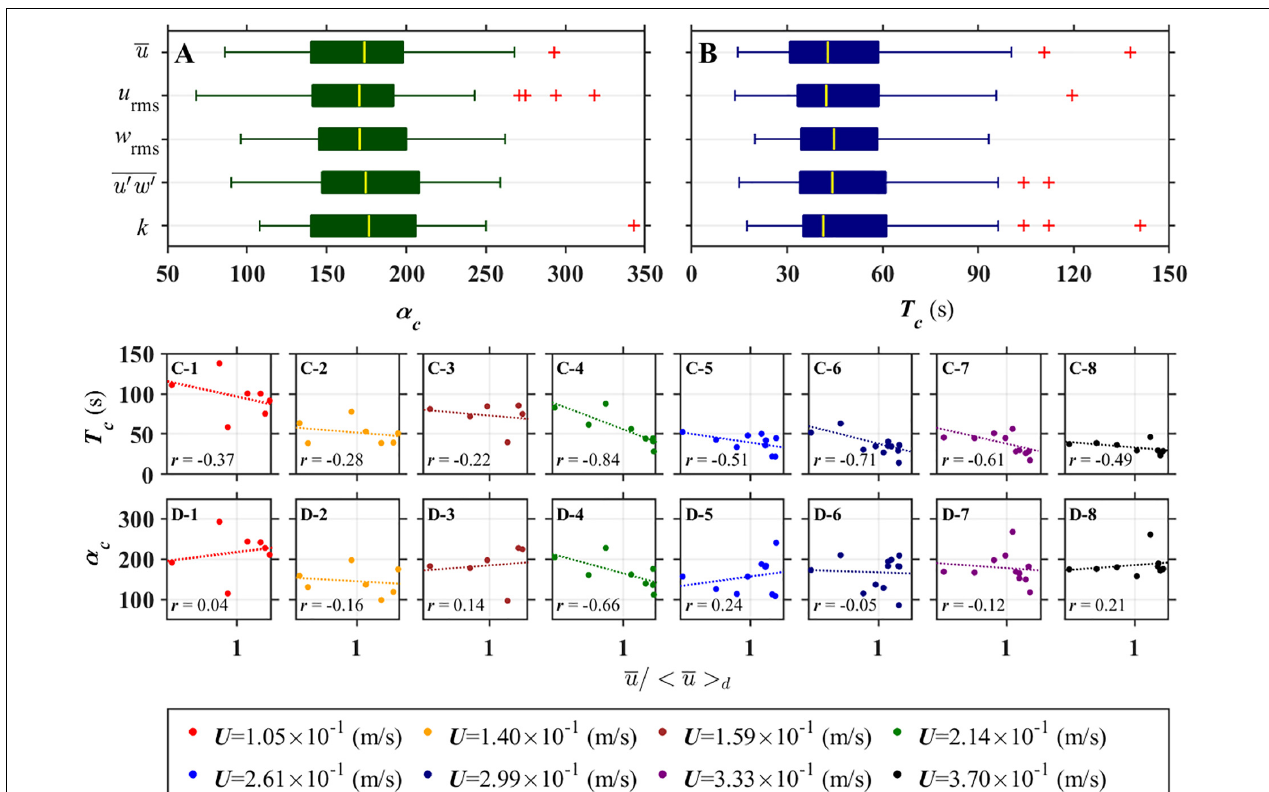
FIGURE 5 | Optimal sampling time of hydraulic parameters represented by (A) α c and (B) real-time scale ( T c ). The red plus signs indicate outliers. The relation between the non-dimensional stream-wise velocity and (C) T c , and (D) α c : r is the correlation coefficient.